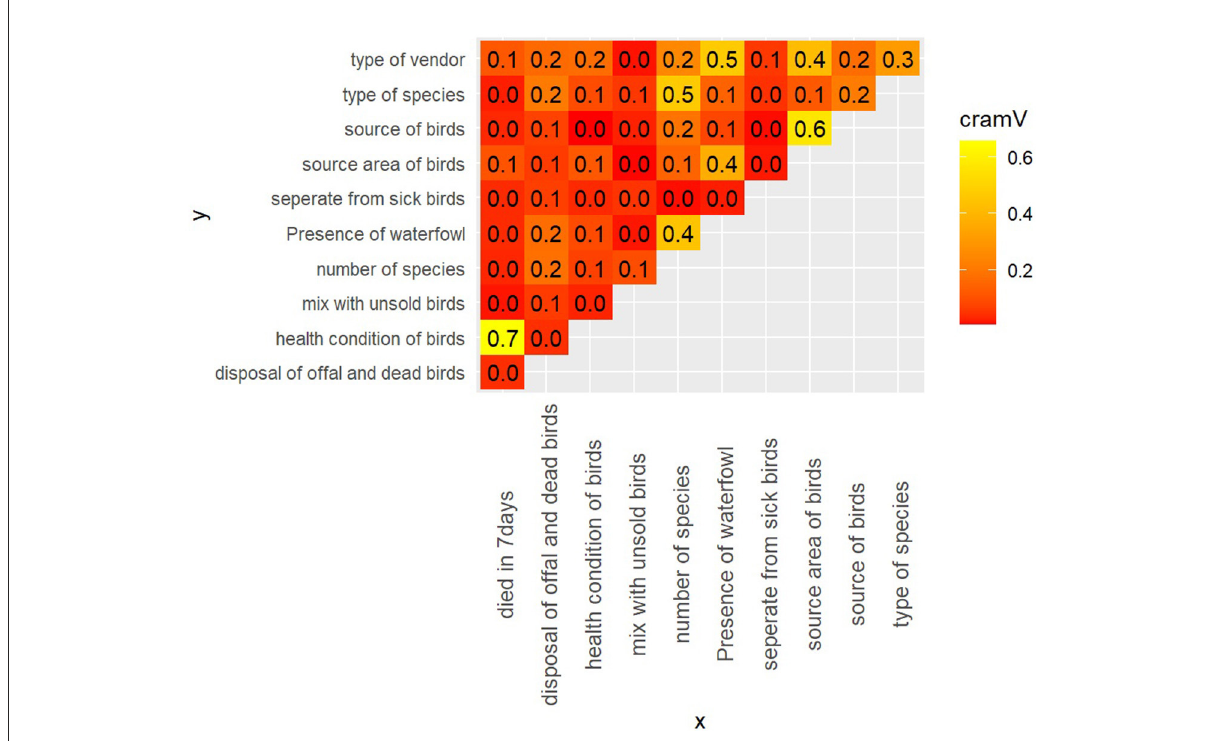
FIGURE4 Value of Cramer’s V between predictor